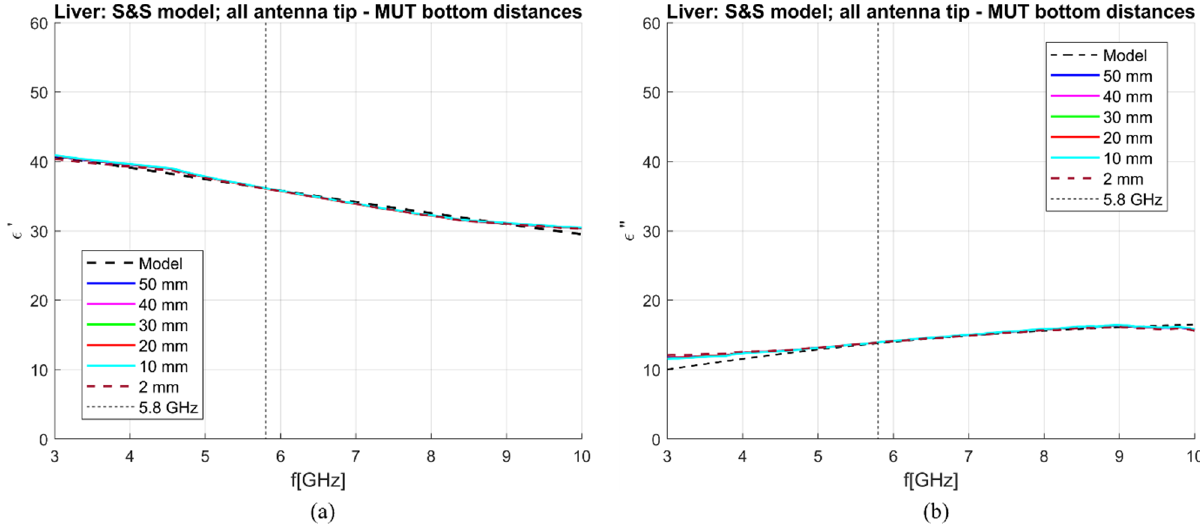
Figure 18. S&S de-embedding of liver simulated in different blocks: ( a ) Calculated vs. reference ε ’ (“real”); ( b ) calculated vs. reference ε ’’(“imag”).